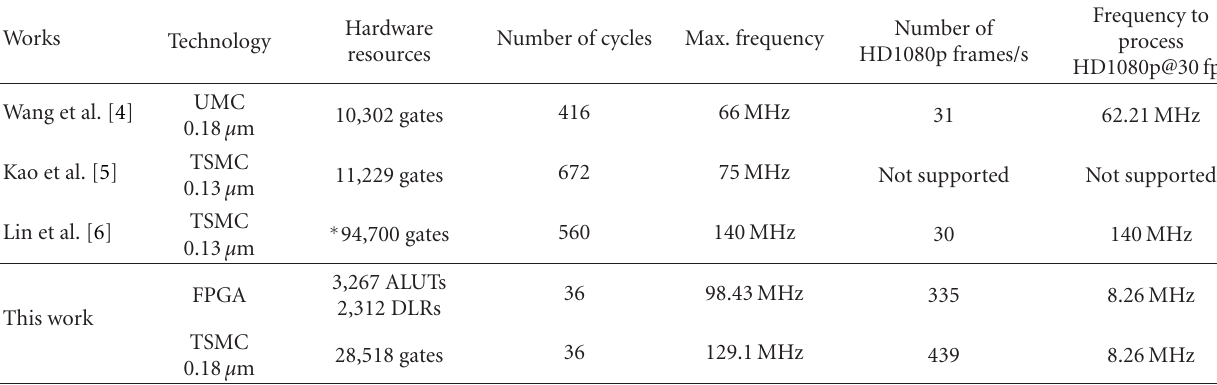
Table 4: Synthesis results and comparison with related works.